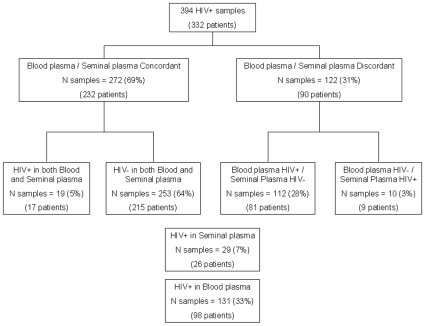
Study flowchart.